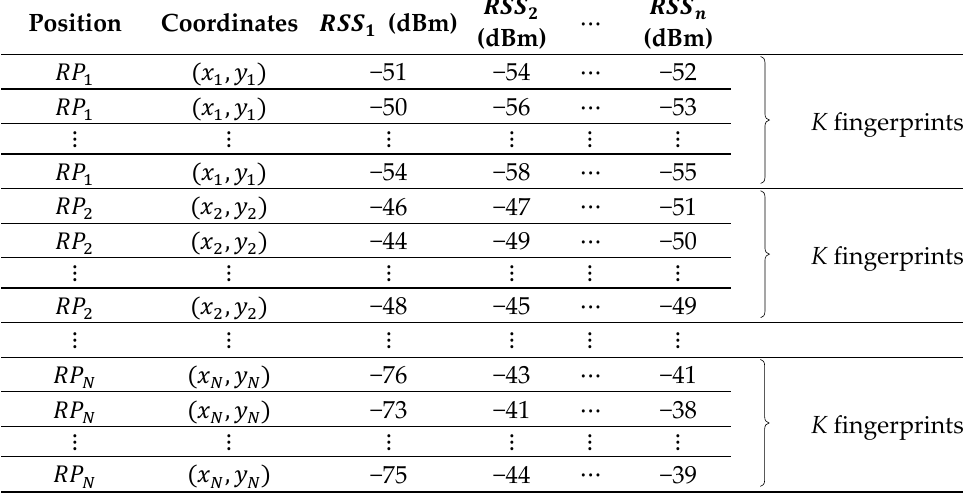
Figure 1. The overall structure of the proposed method. Table 2. The original RSS database. Table 2. The original RSS database.